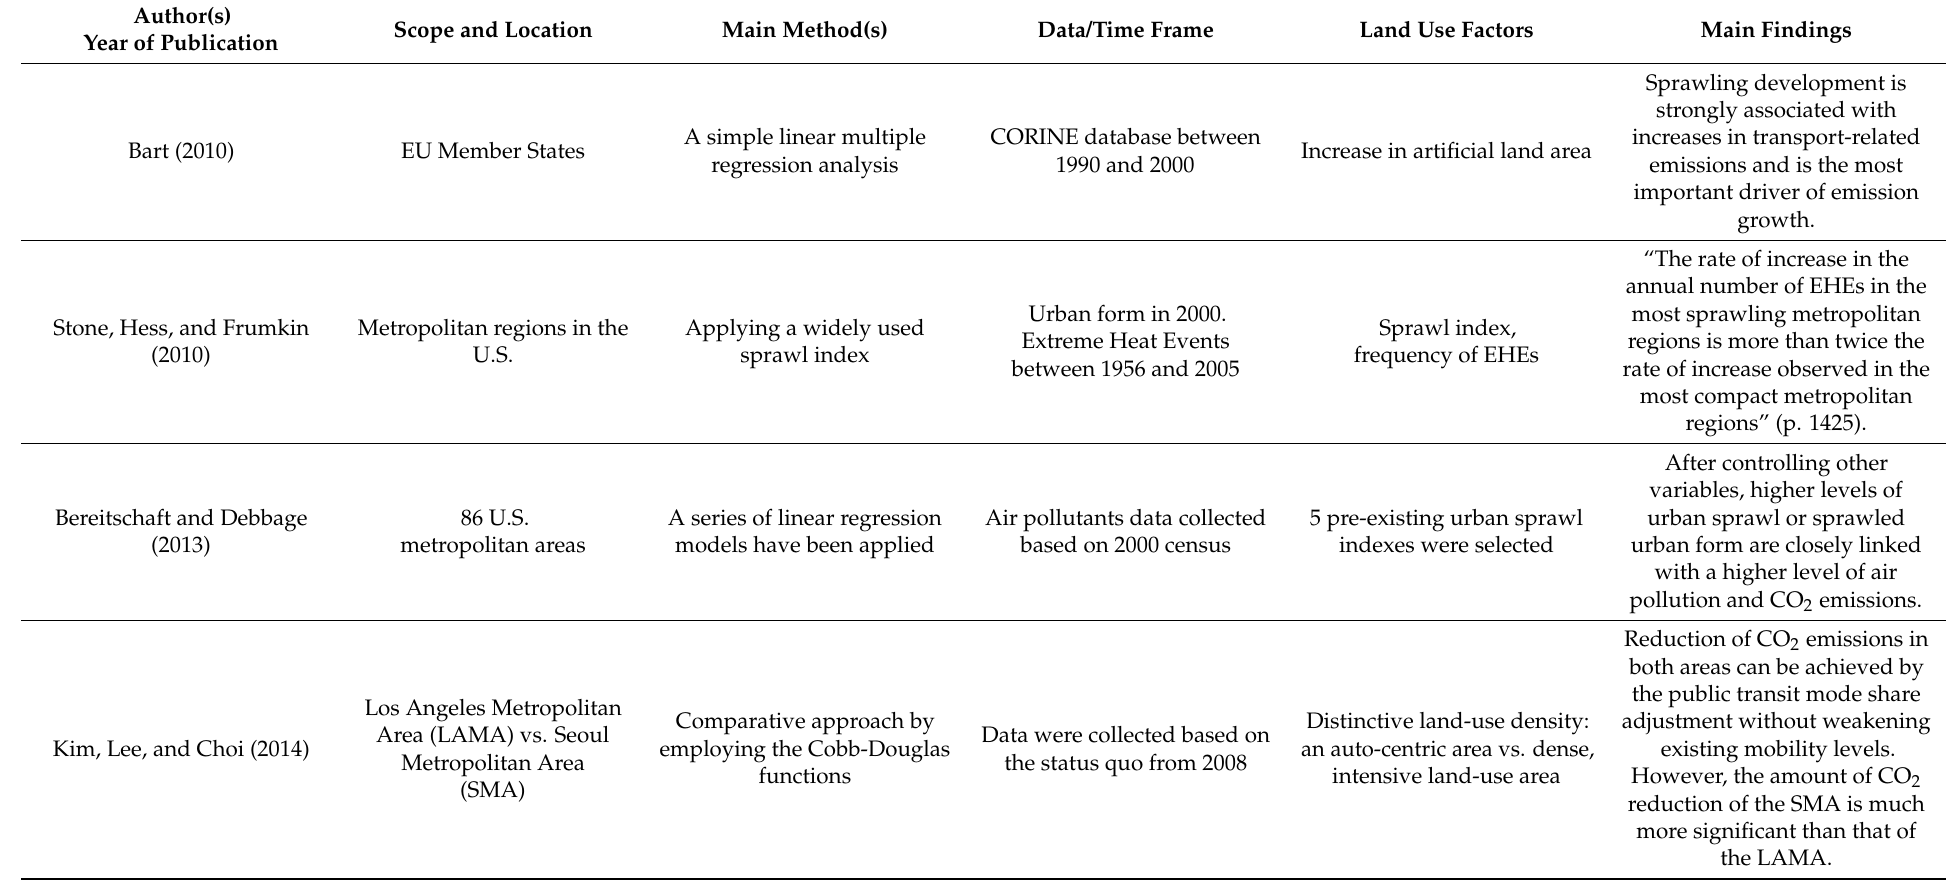
Table 5. The impacts of land use and land cover on fossil energy consumption and GHG/CO 2 emissions [36] (p.